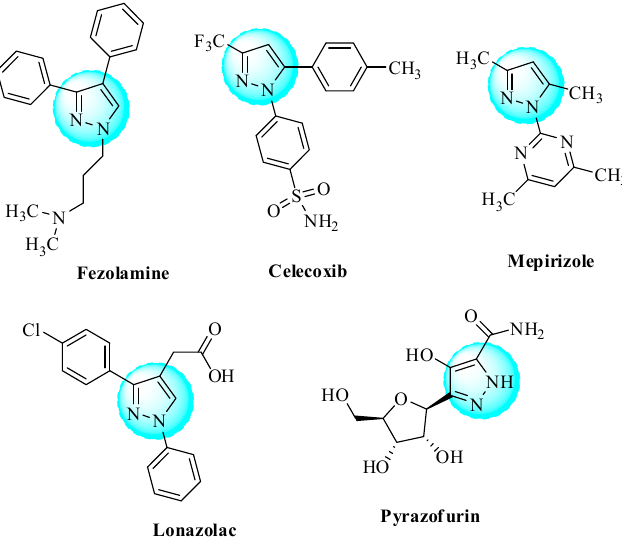
Figure 2. Commercial drug molecules containing pyrazole rings.